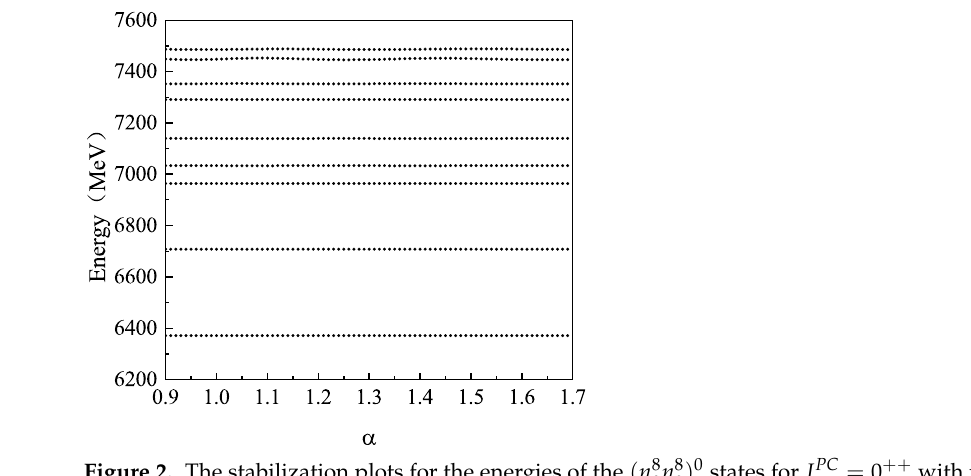
Figure 2. The stabilization plots for the energies of the ( η 8 c η 8 c ) 0 states for J PC = 0 ++ with respect to the scaling factor α .